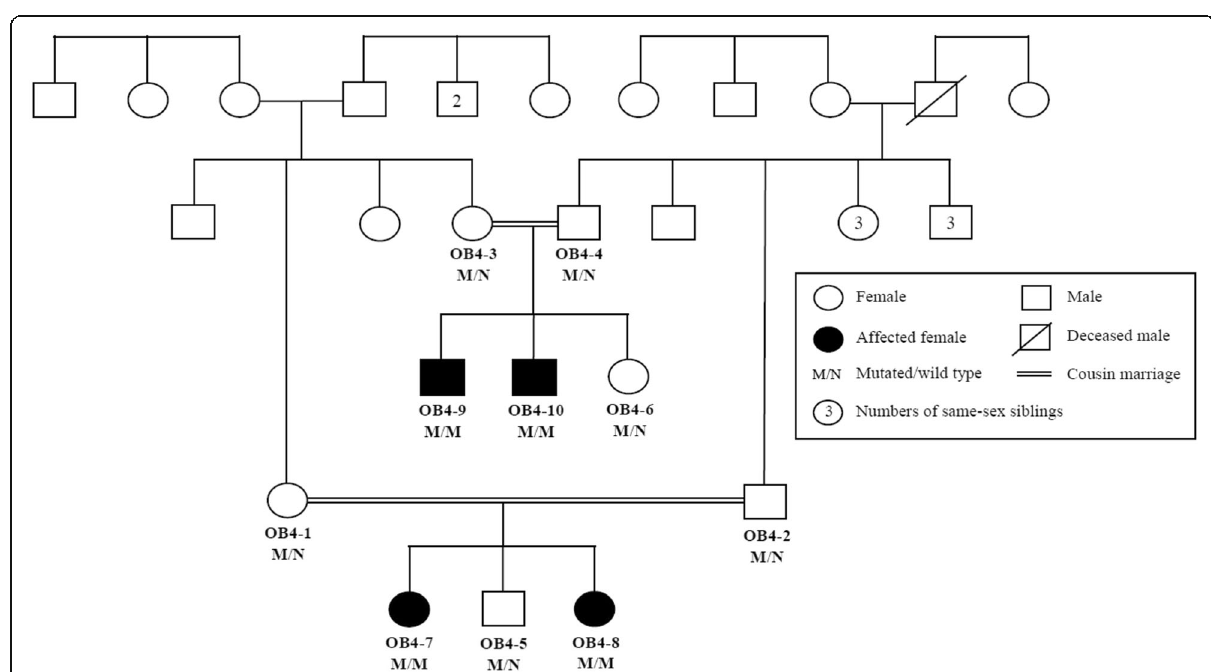
Fig. 1 Pedigree of family OB4 with the frameshift mutation c.3260AG (p.Ser1090Trpfs*6) in